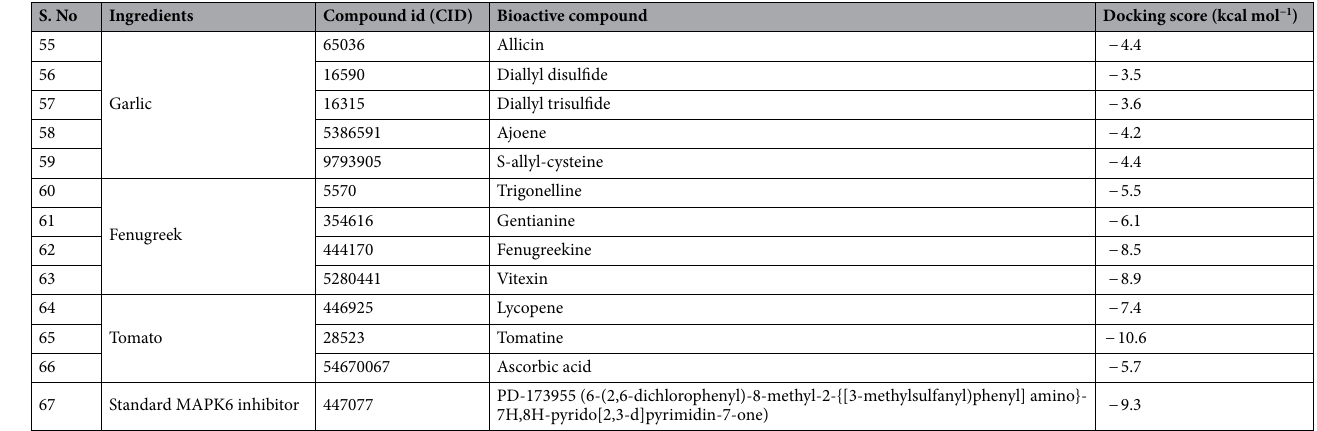
Table 3. Bioactive compounds in Rasam ingredients and their binding affinity against MAPK6.